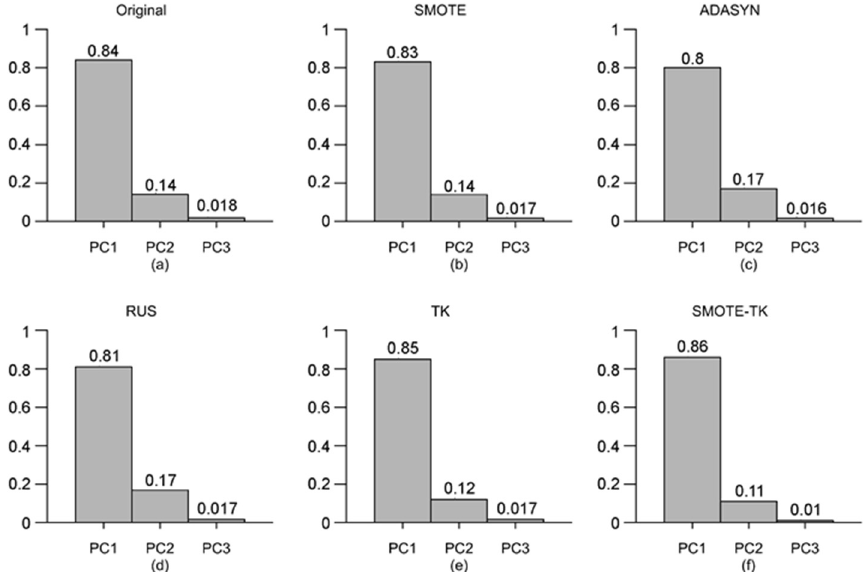
Figure 6. Principal components ranked by variance per original and synthetic datasets: ( a ) Original data, ( b ) SMOTE, ( c ) ADASYN, ( d ) RUS, ( e ) TK and ( f ) Smote-TK.